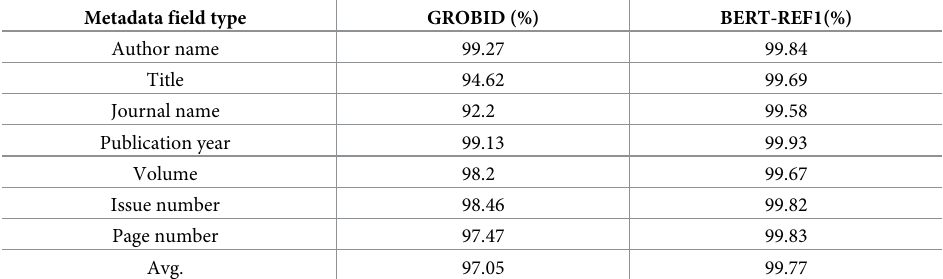
Table 11. Accuracy of the metadata field values extracted from 9,539 English references using BERT-REF1 and GROBID.